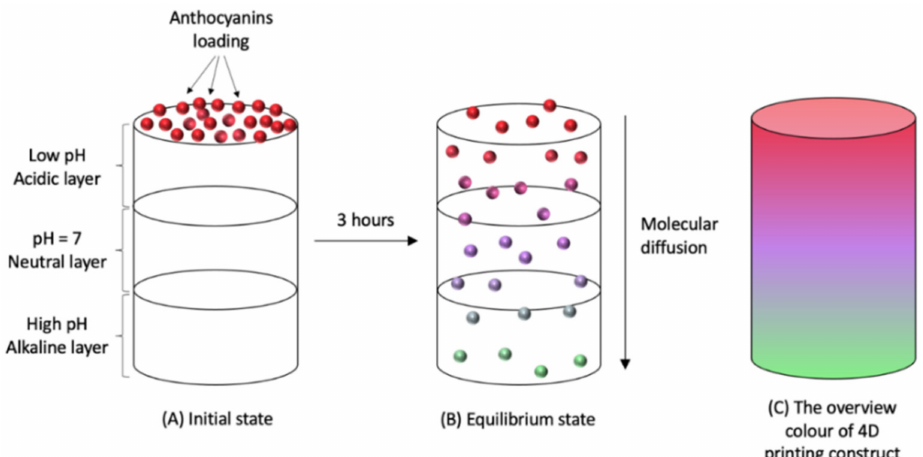
Figure 4. Time-dependent discoloring pattern of anthocyanin in different pH conditions; the scaffold of acidic, neutral, and alkaline layers is constructed by 3D printing. ( A ) Initial state when anthocyanins are just loaded on the top layer. ( B ) When the anthocyanin molecules reached equilibrium state after 3 h by molecular diffusion. ( C ) Overview color of 4D printing construct of